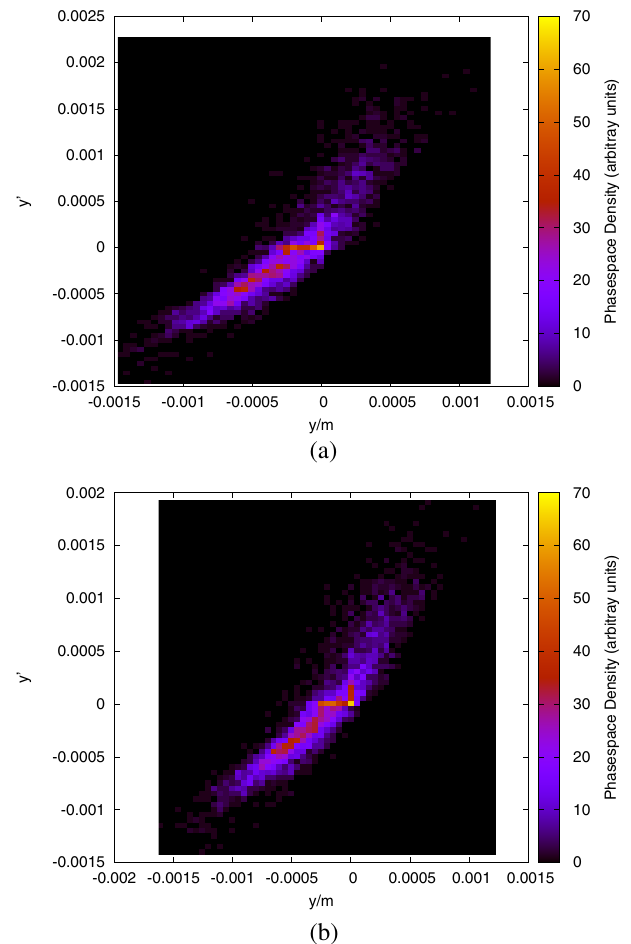
FIG. 4. (Color) TRAFIC4 simulation results for transverse phase- space distributions in the bending plane for fully compressed (a) and overcompressed beams (b); units of y 0 are arbitrary, and the vertical coordinate is the phase-space density (arbitrary units). Also displayed are the phase-space isopycnics, clearly exhibiting the bifurcation in the fully compressed